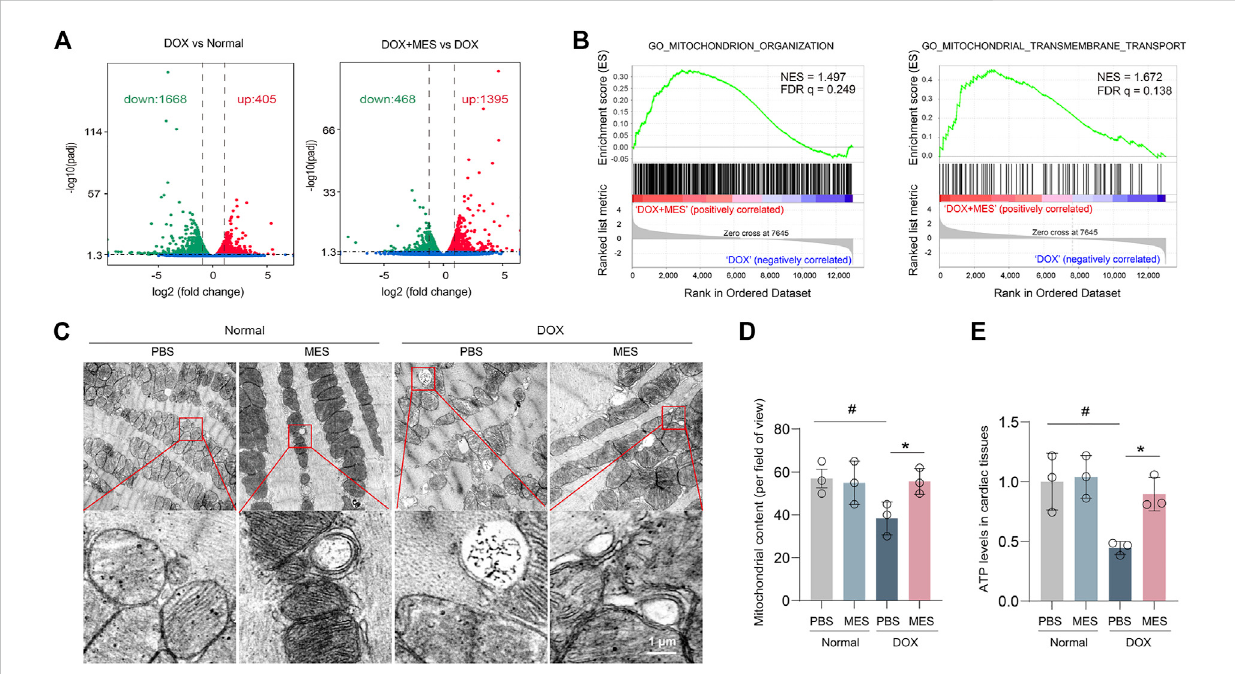
FIGURE 3 Transcriptomepro fi lesofthemyocardiumandprotectiveeffectsofmesaconineonmitochondrialdamage. (A) Volcanoplotofthegene expression values in DOX versus normal hearts (left panel) or DOX + mesaconine versus DOX hearts (right panel). Red, gene expression upregulated; green, gene expression downregulated in myocardial tissues. (B) Gene Set Enrichment Analysis (GSEA) plots of the mitochondrion-related gene modules in the myocardium of mice following the treatment of DOX or DOX and mesaconine. NES, normalized enrichment score; FDR q, false discovery rate q value. (C) Representative TEM images of mitochondria (upper panel) and autophagosomes (lower panel) in heart tissues. (D) The numbers of mitochondrial contents were determined by quantitative analysis. (E) The ATP content in myocardial tissues. Data are represented as means ± SEM of 3 biologically independent replicates assays. *, # p <